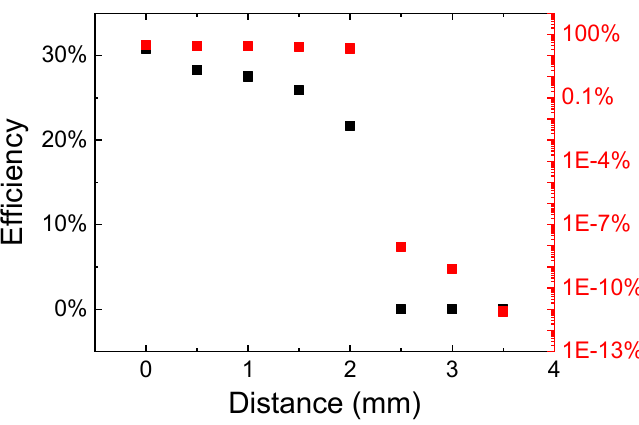
Figure 8. Efficiency, in linear and logarithmic scale, of a commercial Qi wireless power transfer system as a function of the distance between transmitter and receiver.